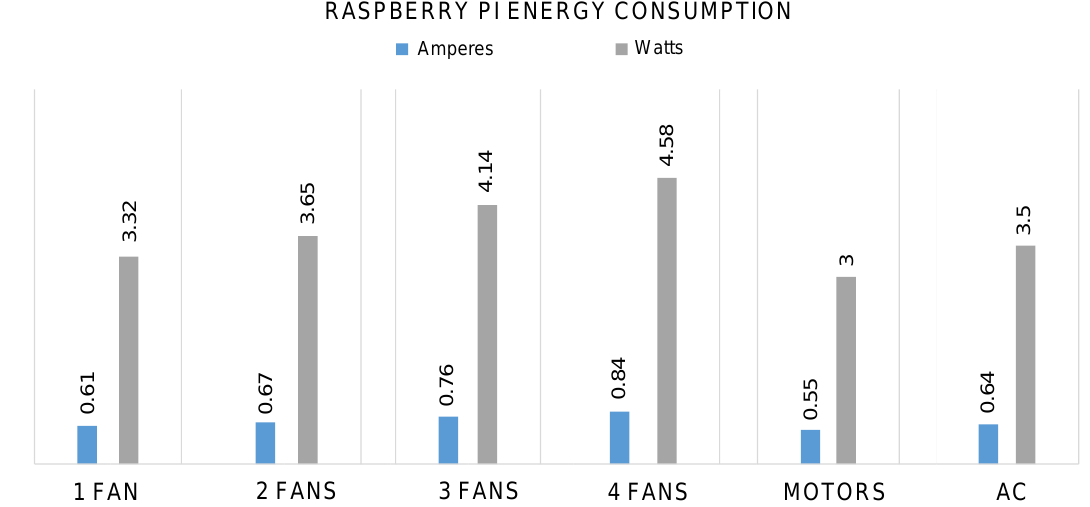
Figure 13. Energy consumption of RPI in terms of amperes, and watts to turn ON fans, motors, and AC.